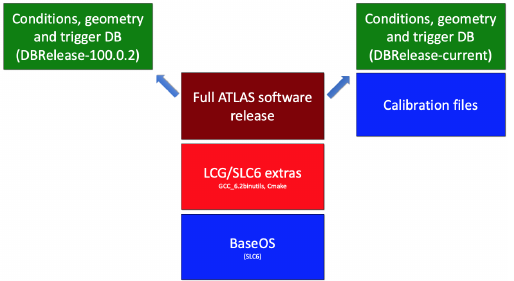
Figure 4. Image production pipeline. Left side for simulation and right side for